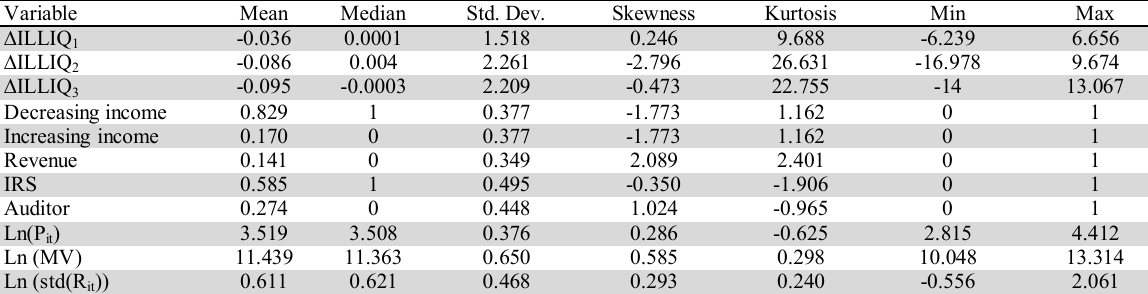
The summary of some basic